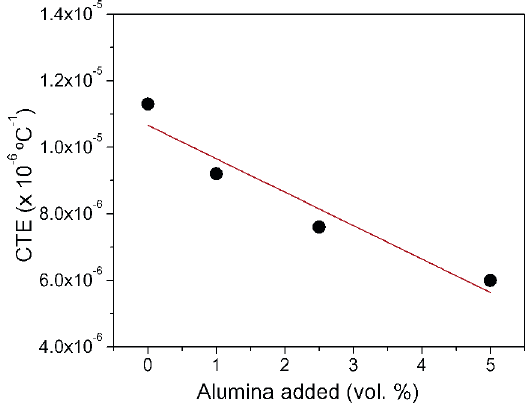
Figure 5. Coefficients of thermal expansion for the LZS glass-ceramic (without Al O ) and for the LZS + Al 2 3 2.5 and 5 vol.% of nanosized Al